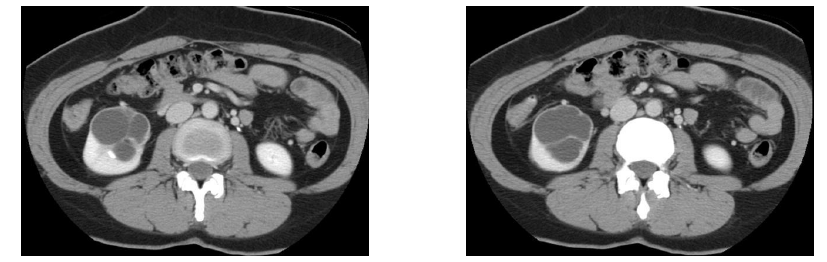
FIGURE 1A and B. Contrast CT images demonstrating a 4.5- × 4.5-cm cystic mass with multiple internal enhancing septations at the inferior pole of the right kidney. Contrast is visible in the collecting system in Fig. 1A.